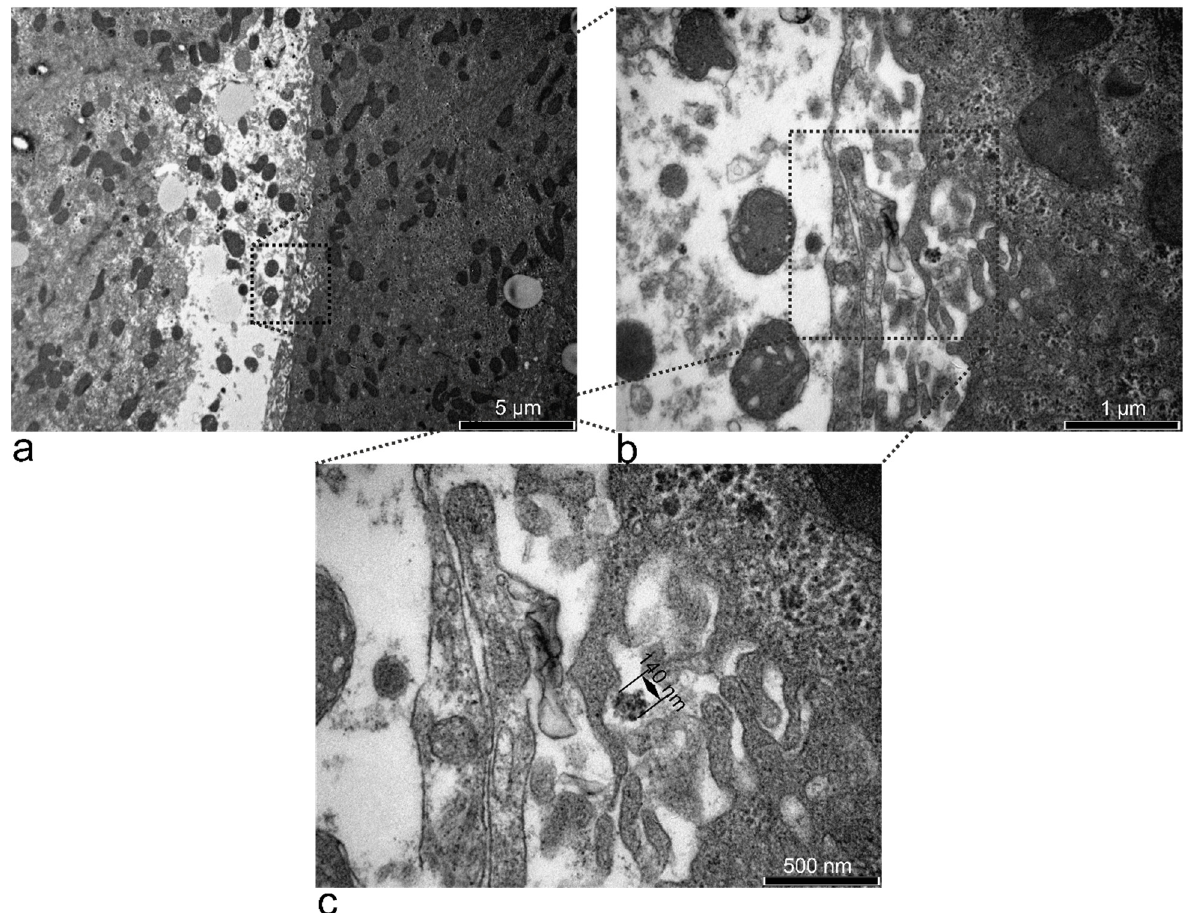
Figure 5. TEM micrographs showing the Disse space (limit between a hepatocyte and a blood vessel) of a rat treated with SPION-PEG clusters for 15 min ( a ). At higher magnification ( b ), microvilli of the hepatocyte seem to have sequestered a small electron-dense cluster that resembles SPIONs-PEG. The cluster was 140 nm in diameter ( c ) and could be a larger nanocluster that maintained its form due to the large fenestrae (~100 nm) of liver sinusoids. At 15, 30, 60, and 180 min, and at 6 h, electron-dense accumulations were detected in hepatocytes, indicating a hepato-biliary-fecal clearance. In contrast, at 12 h, the macro- phages (Kupfer cells) had traces of SPION-PEG clusters (Supplementary Figure S4), which indicates a clearance thorough the reticulo-endothelial-system [39].